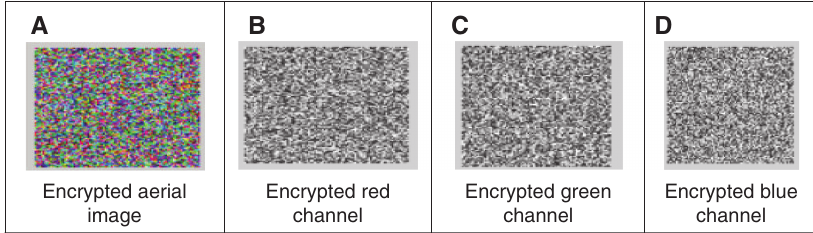
Figure 3: (A–D) Encrypted “Aerial” Image with R, G, and B channels.